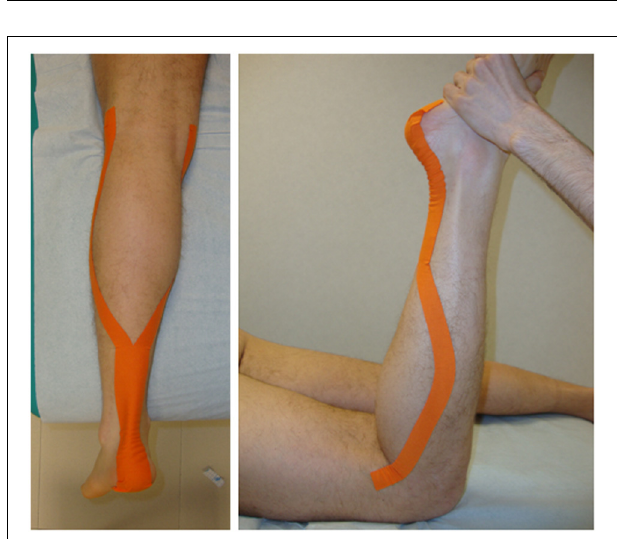
FIGURE 2 | Application of KT and ST tape to soleus and gastrocnemius ankle